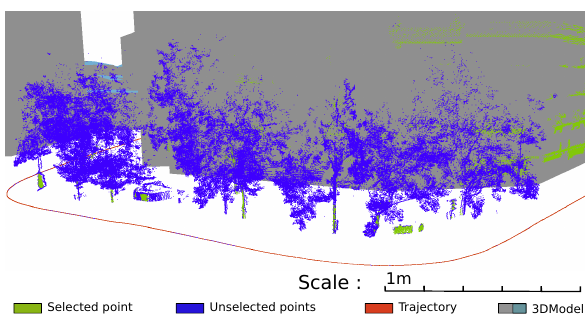
Figure 8: Zoom of part of the geometric descriptor in the scene emphasizing other vertical objects than building façades (poles, trees, panels,